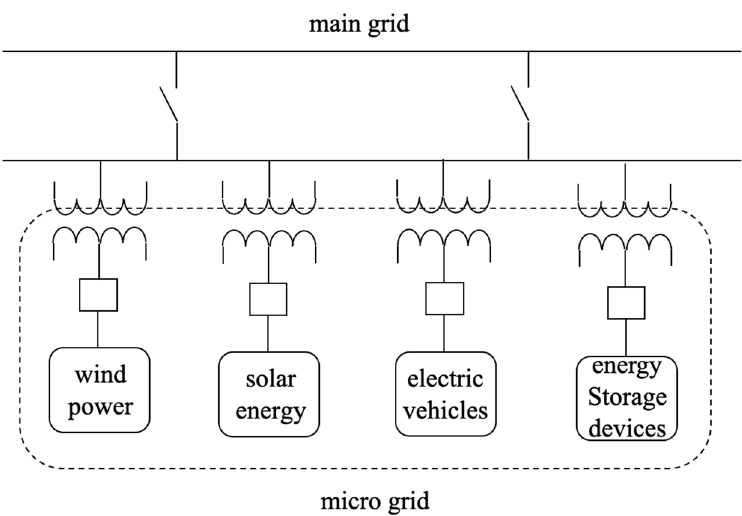
Figure 1. Sample structure of a microgrid connected to a main electric grid.